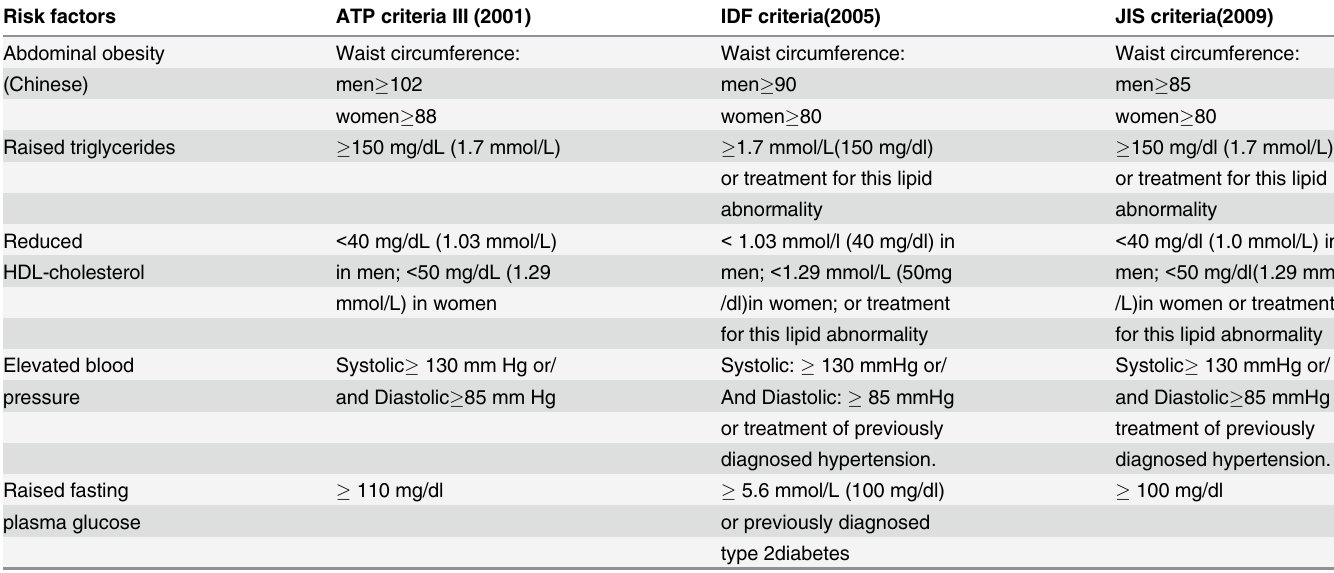
Table 1. Three world-wide definitions of MetS.